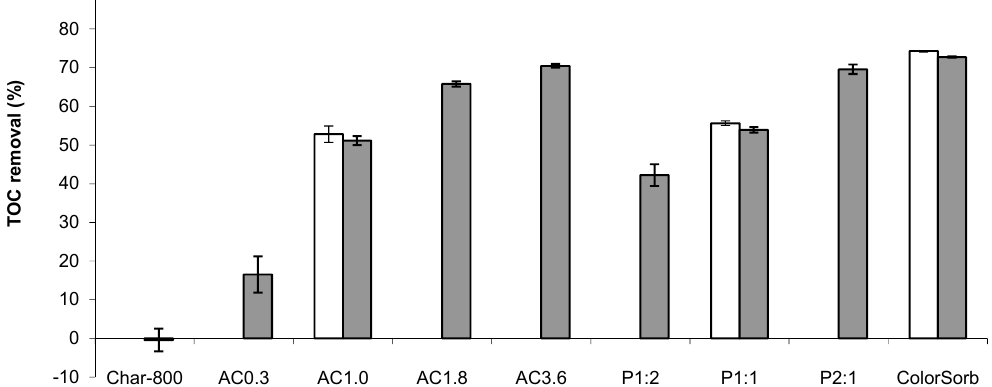
Figure 2. Total organic carbon (TOC) removal by activated carbon from steam assisted gravity drainage (SAGD) water (white and grey bars for as prepared and heat treated (HT) carbon, respectively). Longer activation times with CO 2 and higher H 3 PO 4 :wood ratios increased the TOC removal, which could be attributed to the development of porosity during activation as discussed below.